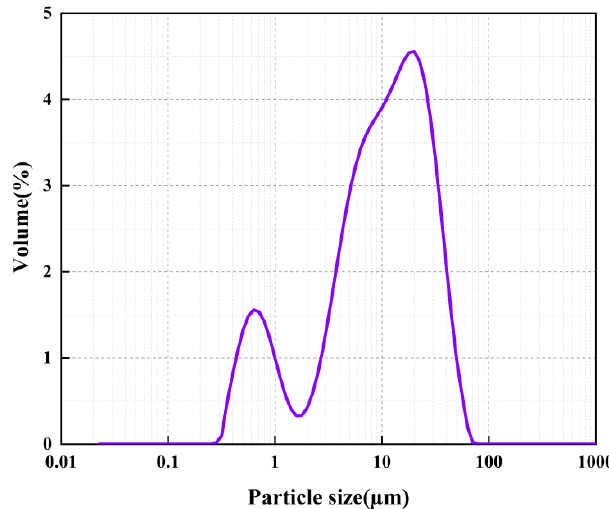
Figure 2. SEM image of C 3 S. Table 1. Particle size of C 3 S.